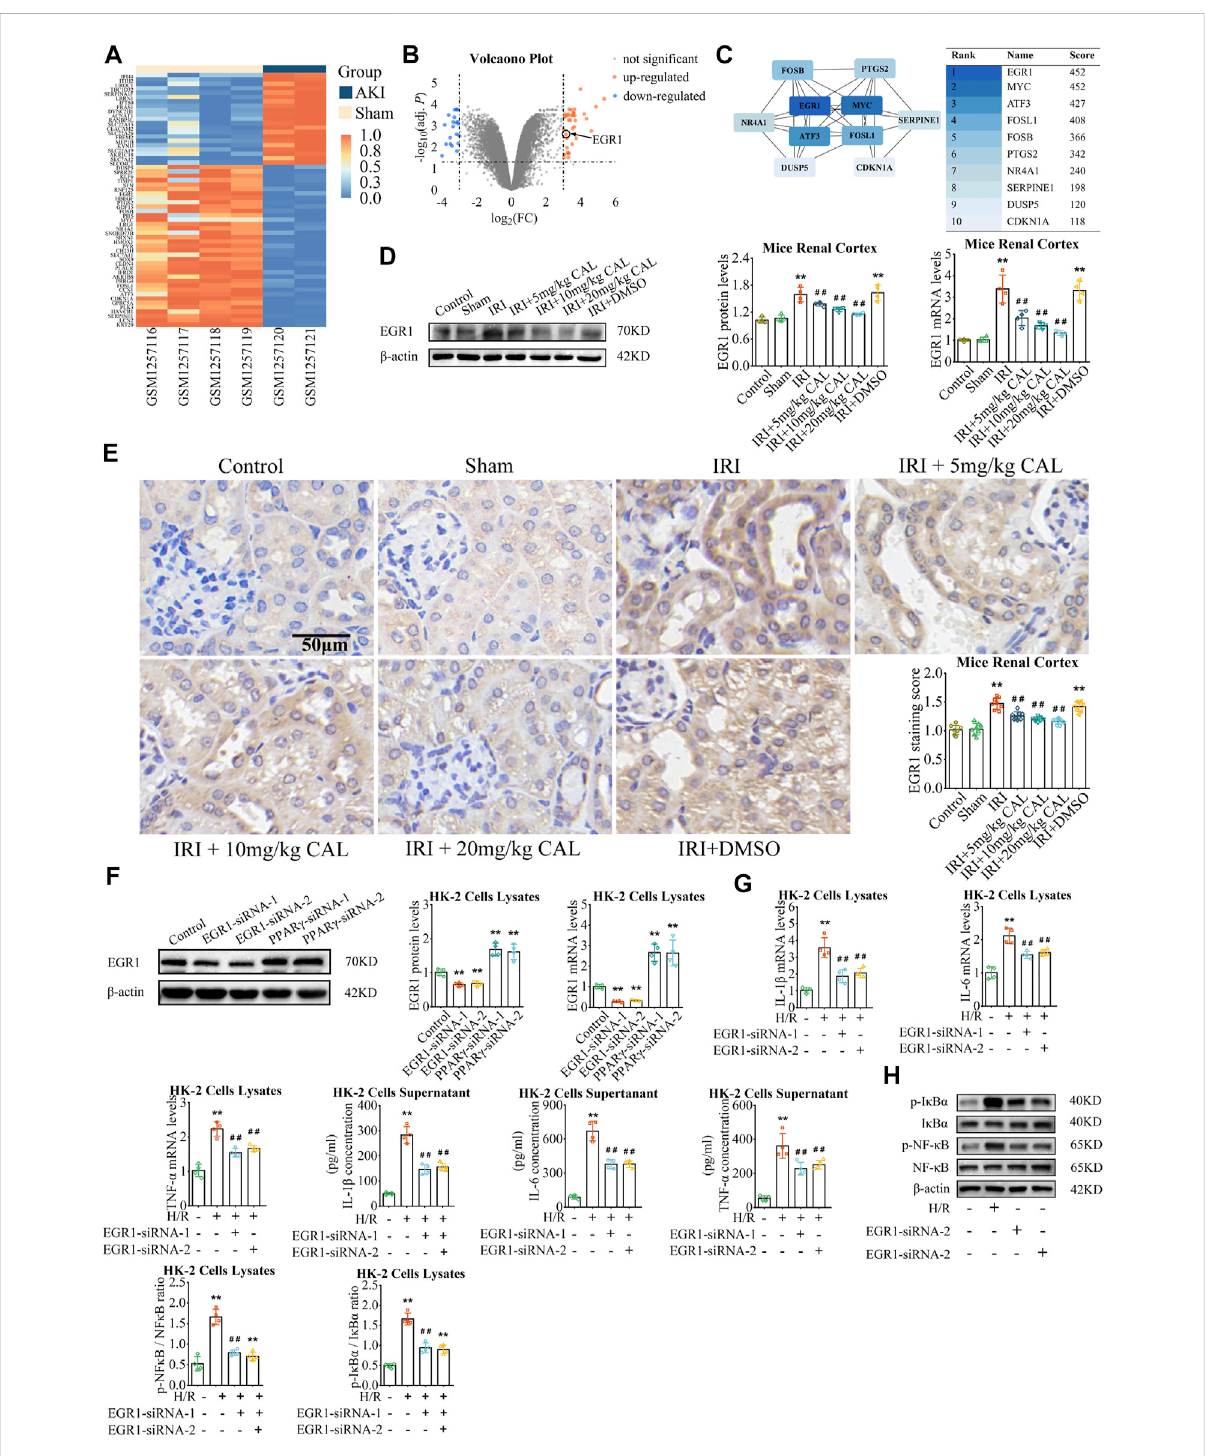
FIGURE 3 EGR1 involved in the anti-in fl ammatory effect of CAL. (A) Heatmap of GSE52004. Absolute log 2 FC > 3 with adj. p < 0.05 was considered the threshold of DEGs (orange: high expression; blue: low expression). (B) Volcanic plot of the DEGs (orange: up-regulated; blue: down-regulated). (C) PPI network of top 10 hub genes selected by the Maximal Clique Centrality method via Cytoscape. (D) The EGR1 protein and mRNA levels in kidney samples of different groups. (E) Immunohistochemistry showed the expression of EGR1 of kidney tissue samples in different groups. Scale bar, 50 µm. ** p < 0.01 vs. sham group. ## p < 0.01 vs. IRI group. n = 8 per group. (F) The protein and mRNA expression of EGR1 in HK-2 cells transfected with EGR1 siRNA or PPAR γ siRNA. ** p < 0.01 vs. control group (G) IL-1 β , IL-6, and TNF- α mRNA levels in cell lysates and IL-1 β , IL-6, and TNF- α concentrations in cell supernatant of different groups. (H) The protein levels of p-NF- κ B/NF- κ B and p-I κ B α /I κ B α in cell lysates of different groups. ** p < 0.01 compared with control group. ## p < 0.01 compared with the H/R group. n = 4 per group. The data are presented as the mean ±